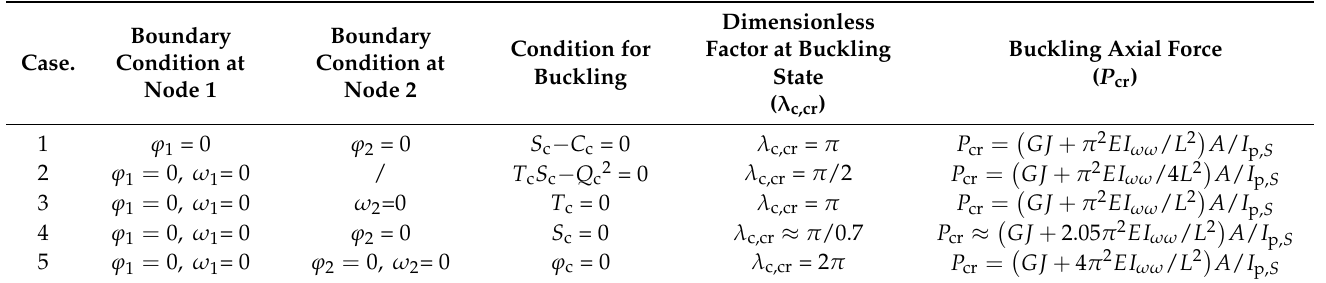
Table 1. Analysis of torsion-warping-axial stability problems with typical element-end boundary